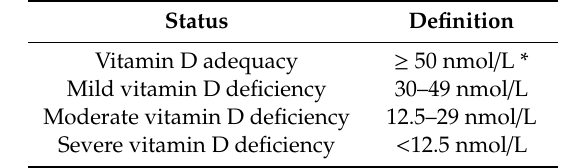
Table 1. Definitions of vitamin D deficiency according to the Australian and New Zealand Bone and Mineral Society and Osteoporosis Australia